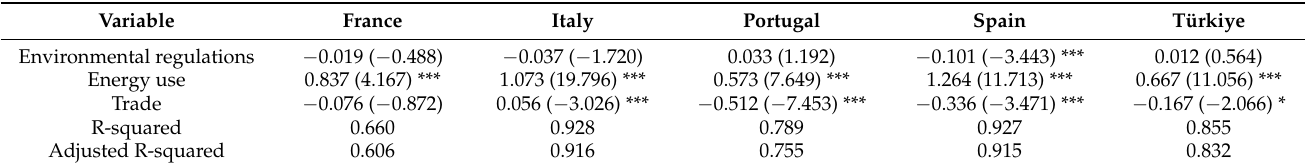
Table 7. Country-level estimations using FMOLS analysis. Independent variables are in logarithmic terms. T-statistics are in parentheses. Dependent variable is ecological footprint in logarithmic